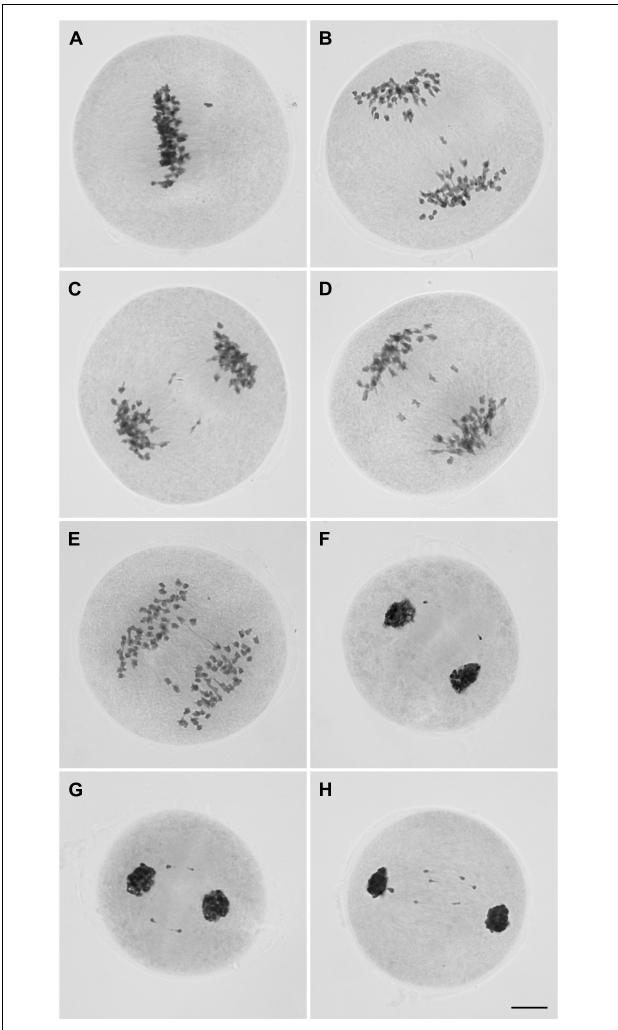
FIGURE 3 | Microsporocytes of IACSP93-3046 during meiosis I showing a chromosome not lined up at the metaphase plate (A) , lagging chromosomes (B-D), and a chromosome bridge in cells at anaphase I (E) . Chromosomes outside the telophase I nuclei (F–H) . Bar, 10 µ